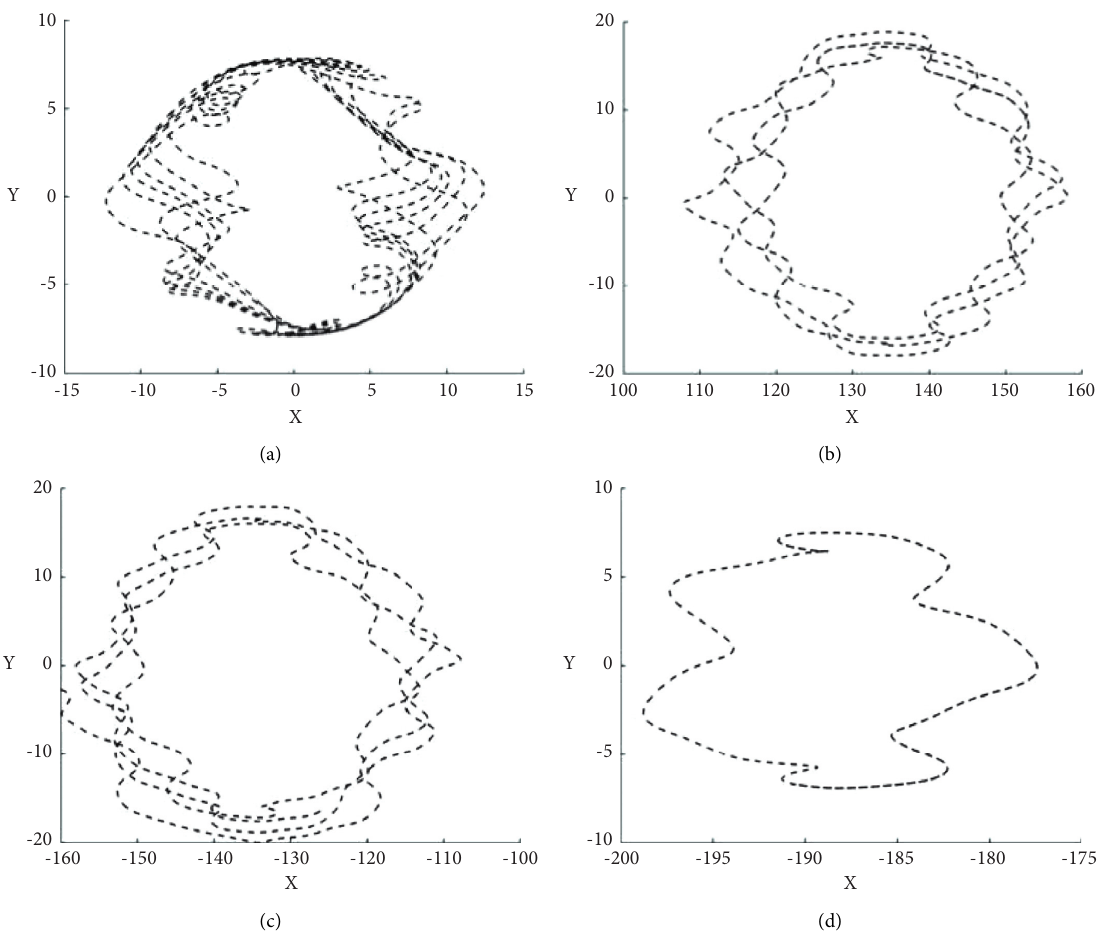
Figure 10: Phase portrait in the plane ( x,y ) for System (2) illustrating megastability obtained by considering random initial conditions distributed around the x -axis. The frequency of the forcing term is ω � 0 . 6, and the amplitude A � 2. Adding a forcing term can make the system exhibit various